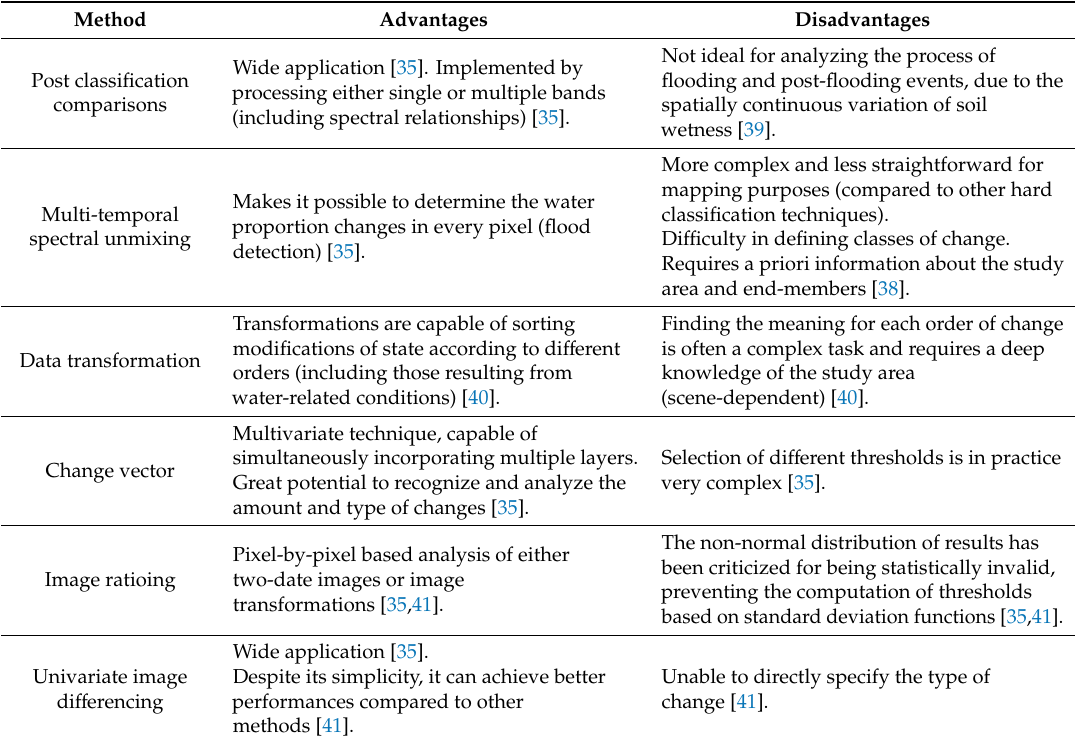
Table 1. Advantages and disadvantages of bi-temporal change detection